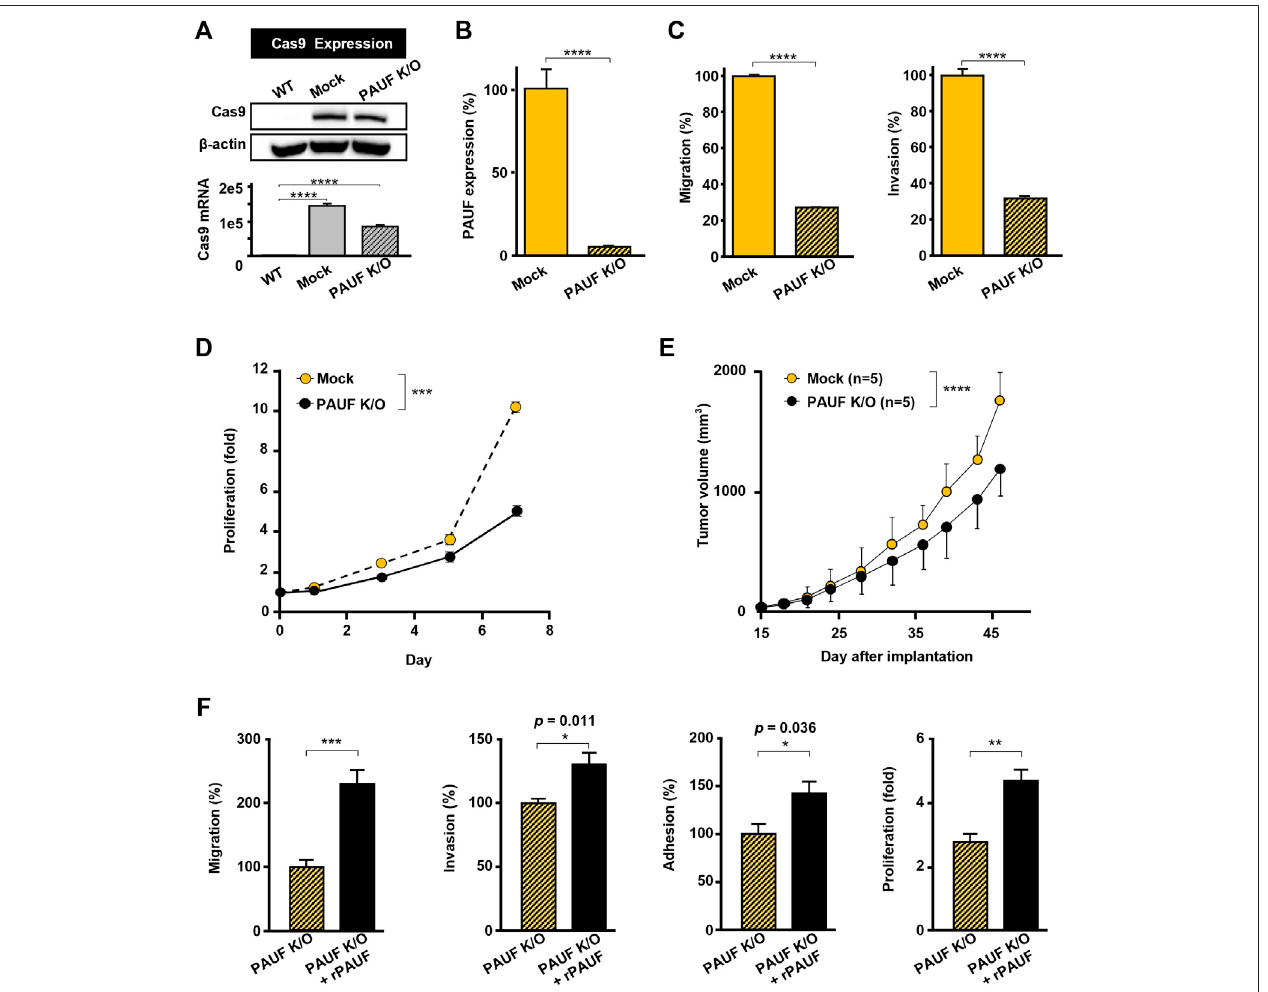
FIGURE 2 | Knockout of PAUF caused loss of malignant traits in OVCAR-5 ovarian cancer cell, which was restored by recombinant PAUF (rPAUF) treatment. (A) Western blot (upper) and RT-PCR (lower) assays of Cas9 in OVCAR-5 wild-type (WT, without Cas9 transduction), Mock (only Cas9 transduction), and PAUF K/O (Cas9 transduction+PAUFgenedeletion)cellstoindicateasuccessfultransductionofCas9protein.Theoriginalimagesofblotsareshownin SupplementaryFigureS2 . (B) SandwichELISAofPAUFexpressioninOVCAR-5MockandPAUFK/Ocells. (C) MigrationandinvasionofMockandPAUFK/Ocells. (D) ProliferationofOVCAR-5 Mockand PAUFK/Ocancercells invitro weresigni fi cantlydifferent, analyzed usingalinearmixedmodel. (E) TumorgrowthinOVCAR-5 Mock andPAUF K/Oxenograft mouse models were signi fi cantly different, analyzed using a linear mixed model. (F) Effects of rPAUF (0.5 μ g/ml) on migration, invasion, adhesion, and proliferation of OVCAR-5 PAUF K/O cells. p p < 0.05, pp p < 0.01, ppp p < 0.001, pppp p <